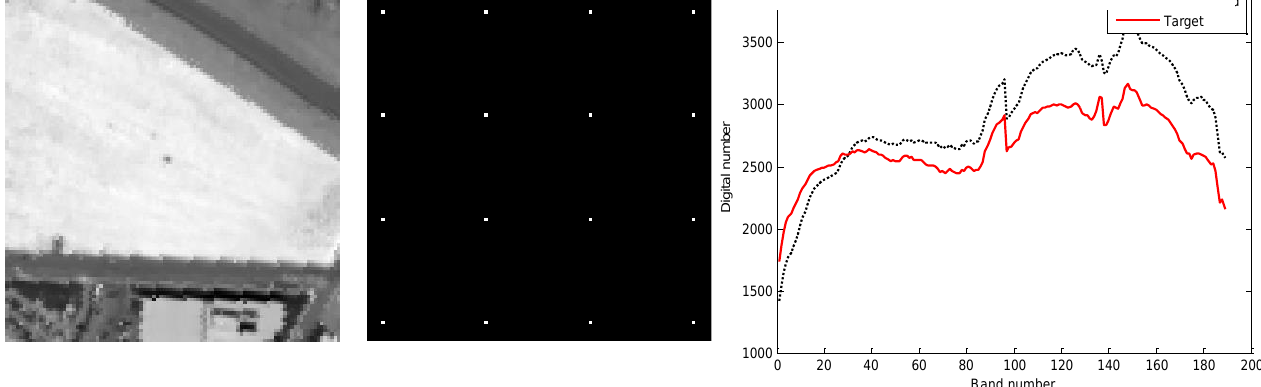
Figure 1. The grey level image, target map, and the spectral signatures of target and background in synthetic